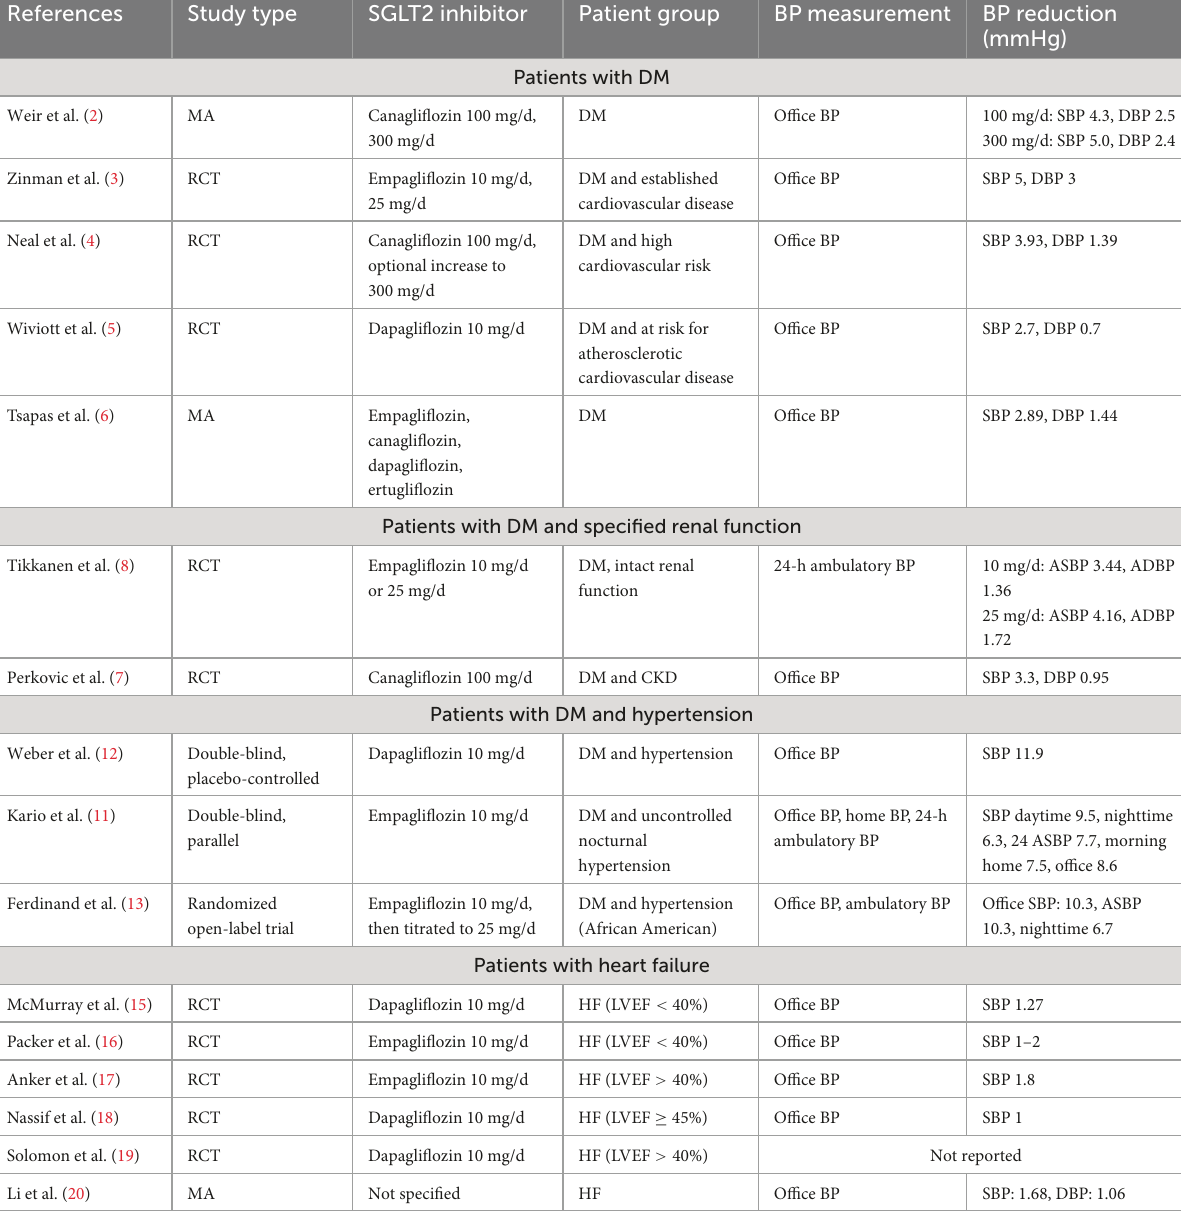
TABLE 1 Sensitivity analyses of the associations between genetically predicted iron status and mental disorders.